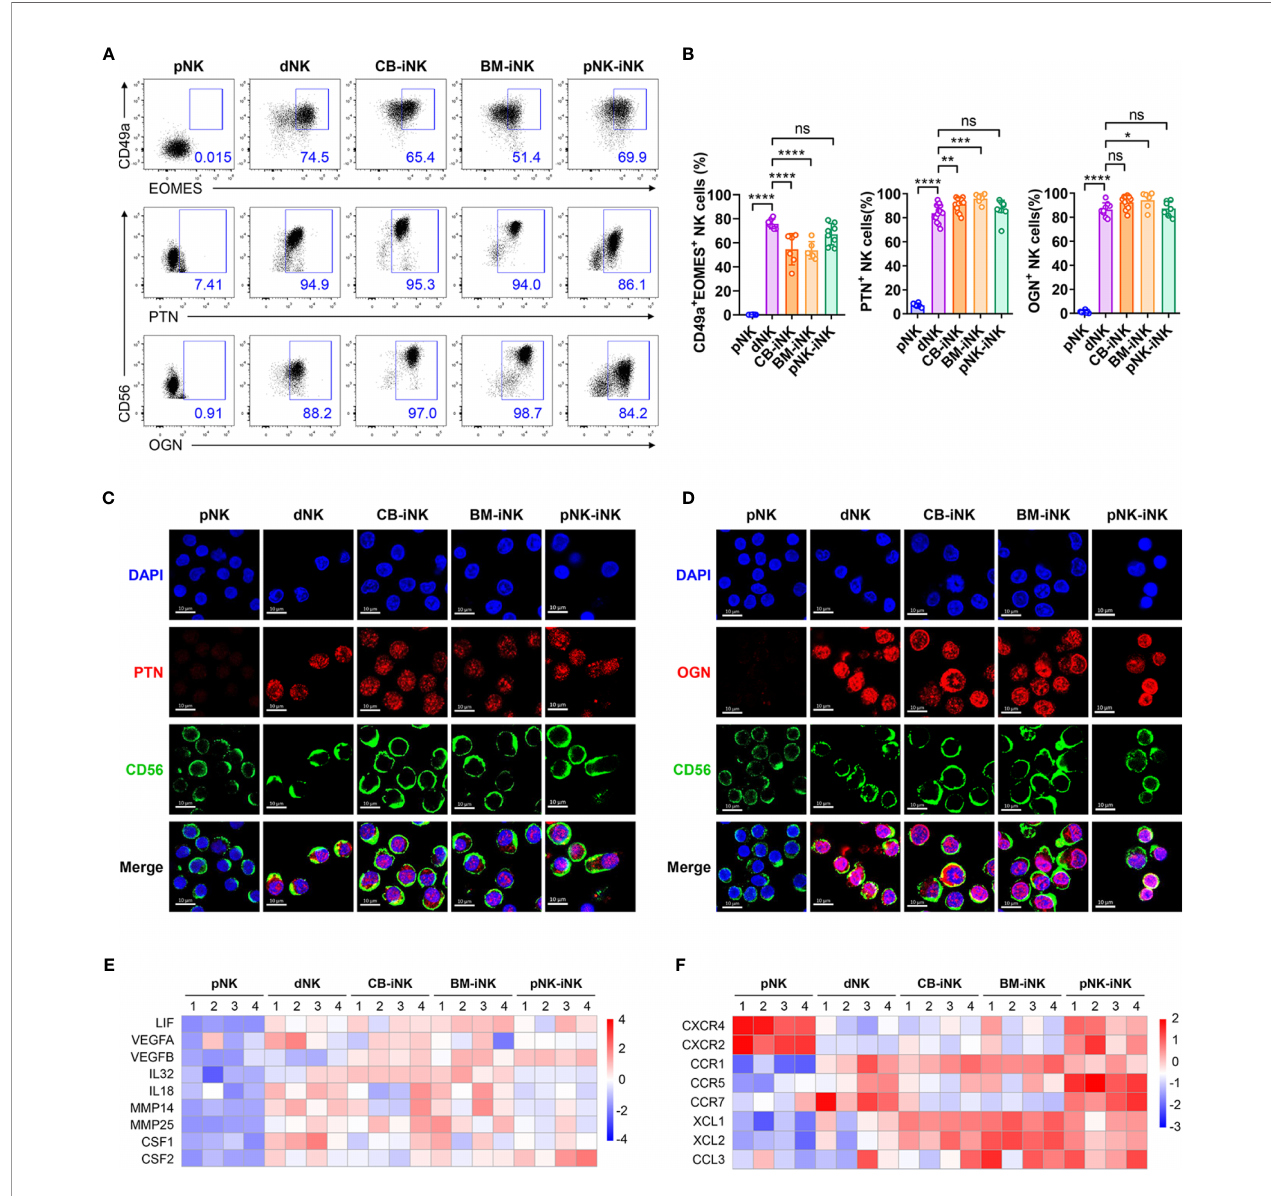
FIGURE 4 | The iNK cells have high expression of GPFs, proangiogenic factors, chemokines and chemokine receptors like dNK cells. (A, B) The percentage of CD49a + EOMES + and GFP + NK cells in each group was tested by fl ow cytometry. Representative density plots (A) and statistical calculation of all samples (B) . Data represent means±SD, n ≥ 6 in each group. Data were analyzed by one-way ANOVA. *p < 0.05; **p < 0.01; ***p < 0.005; ****p < 0.0001; ns, not signi fi cant. (C, D) CLSM images showing the secretion of PTN (C) and OGN (D) in pNKs, dNKs and other iNKs. Scale bars, 10 m m. (E) Some genes encoding the proangiogenic factors were selected for heat map analysis. (F) Some genes encoding the chemokines and chemokine-receptors were selected for heat map